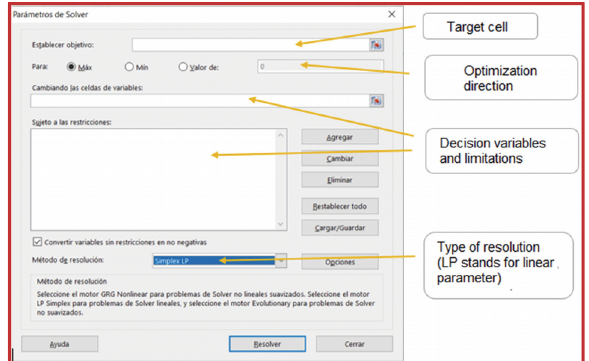
Figure 6. Solver User’s Guide